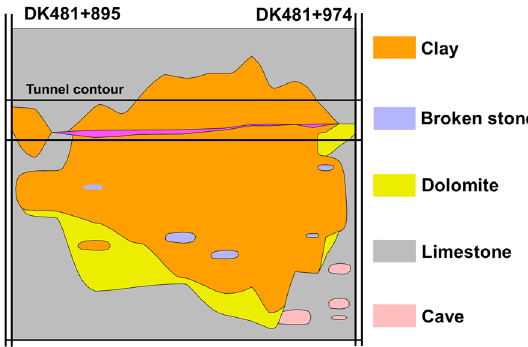
Figure 6. The schematic diagram of Changqingpo Tunnel.